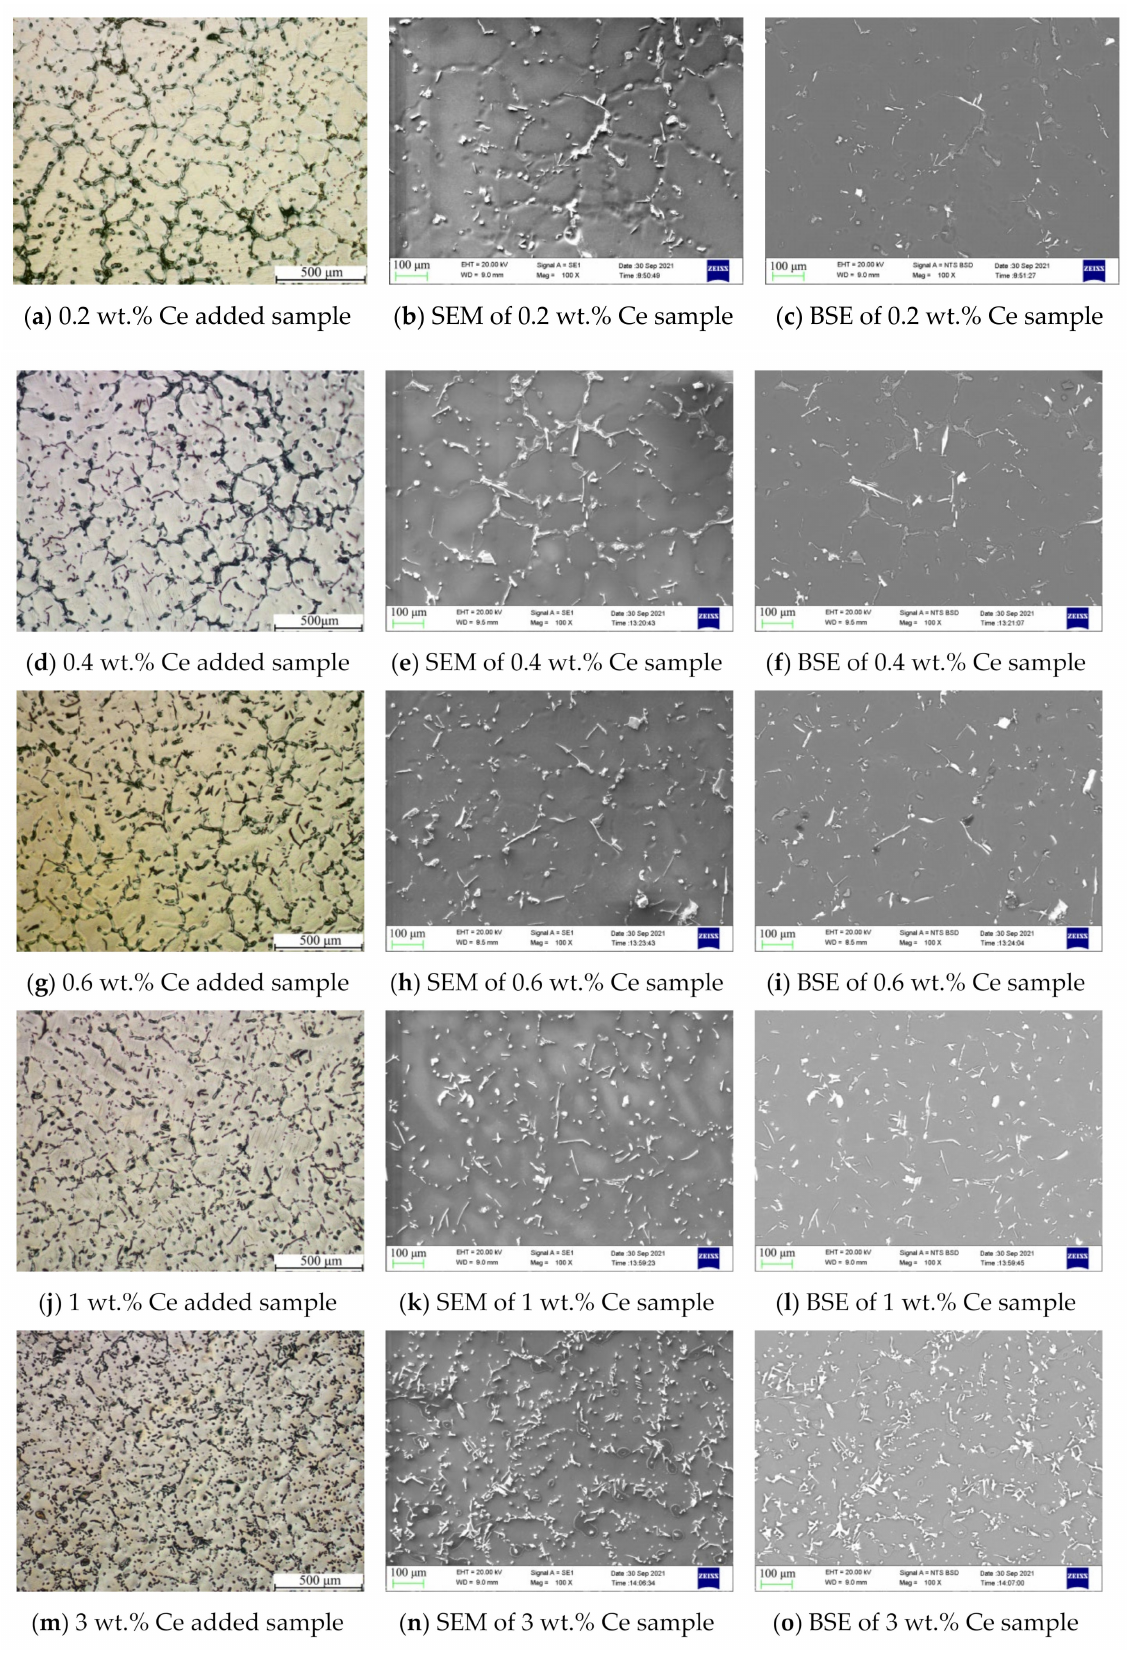
Figure 4. Metallographic and precipitated phase diagram of samples with different Ce